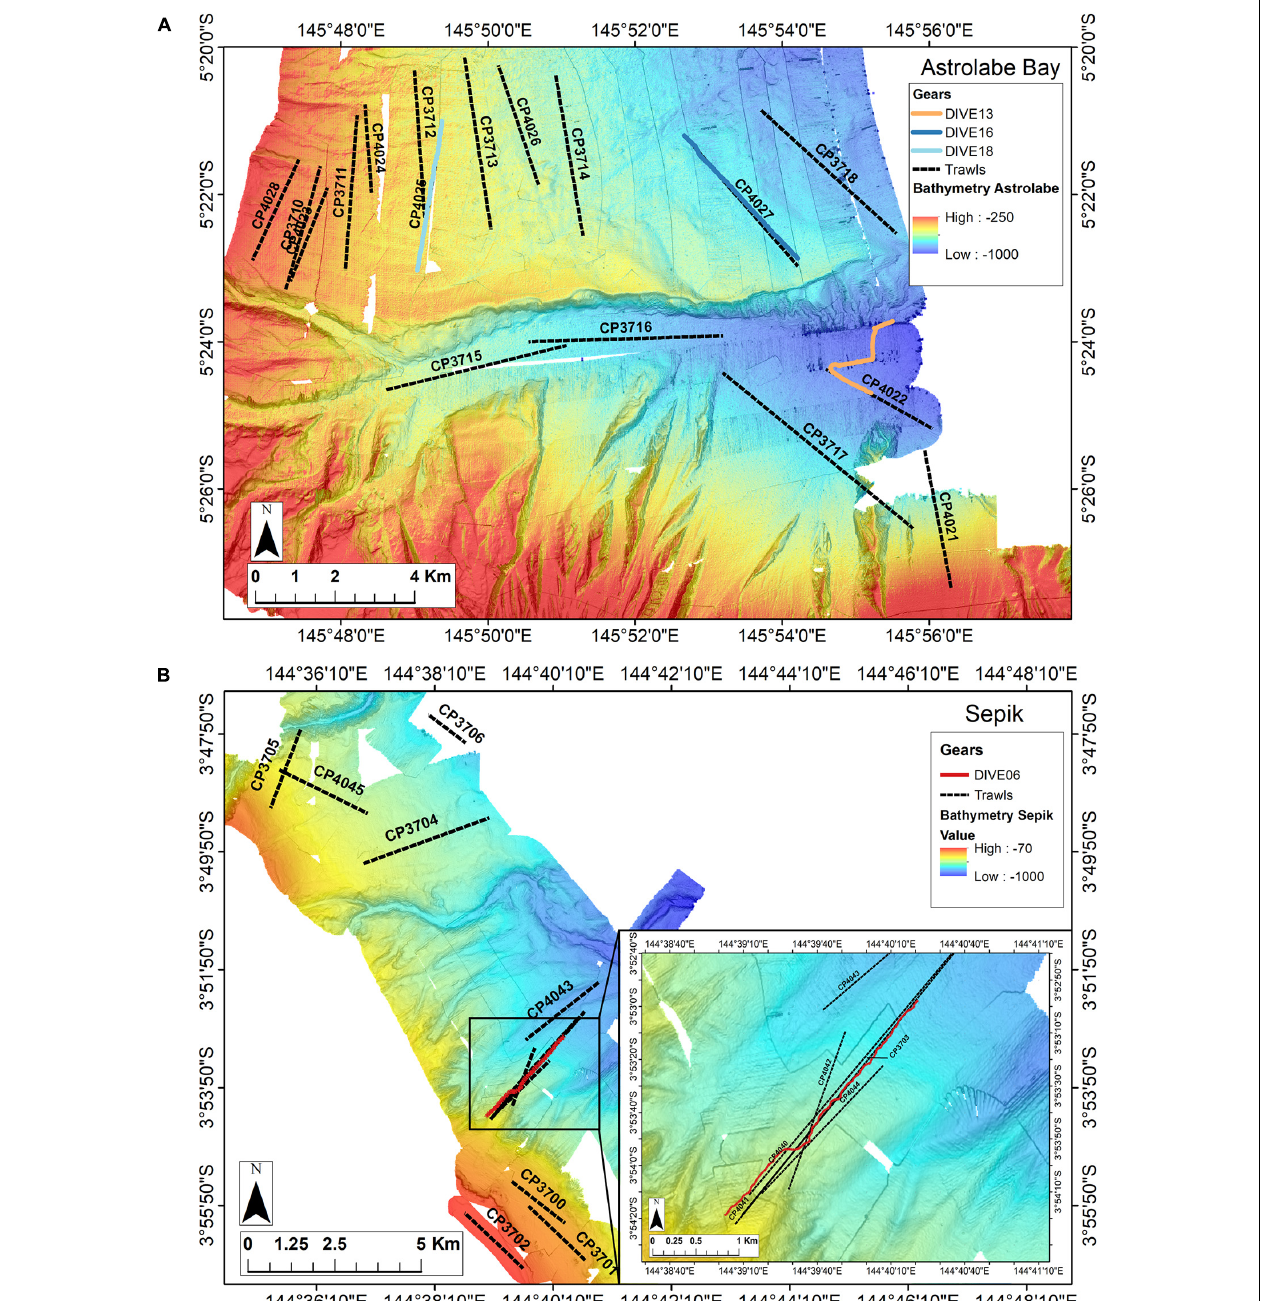
FIGURE 1 | Locationof the camera transects and dredge/trawl transects operations (dive, sampling along dive and in the surrounding area): Panel (A) in the Astrolabe Bay and panel (B) in the Sepik River area (Broken Water Bay). Colored lines represent camera transects, black dotted lines represent dredging (DW) and trawling (CP)